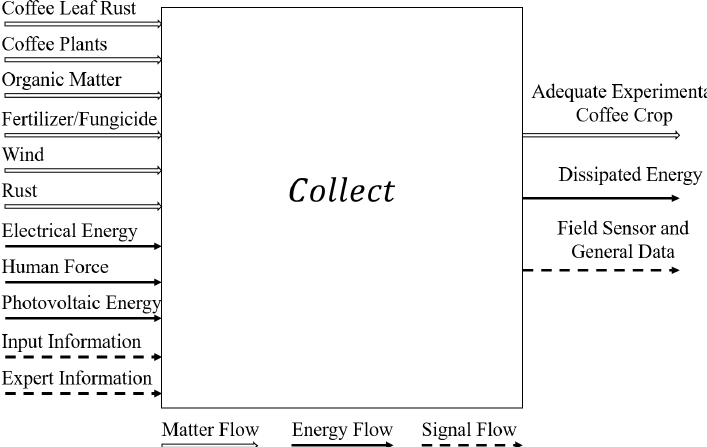
Figure 1. Black box representation of the cyber-physical data collection